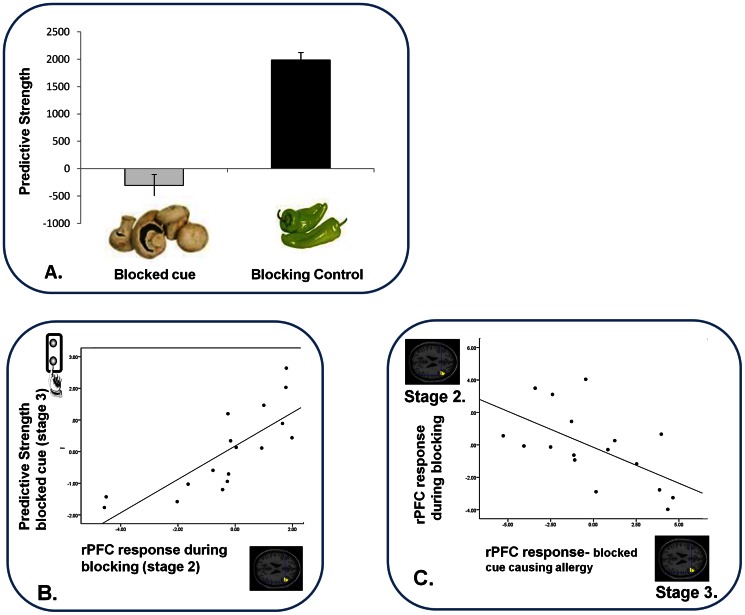
Blocking Behavior and its Relation to Brain Responses.
A. Behavioral Predictions For Blocked and Control Cues. Subjects predicted with low confidence about the blocked cue, when exposed to it at Stage 3; confirming that blocking had taken place. Error bars represent SEM. Y-axis represents subjects' predictive strength; their degree of confidence (duration of predictive button push response) multiplied by correctness of their prediction. Hence lower scores reflect uncertain and unstable predictions, which we observed to blocked cues when compared with blocking control cues (whose causal association with the allergy is more robust). B. Relating Predictions about the Blocked Cue (Stage 3) to Blocking Responses. Subjects who showed the lowest confidence when predicting what would happen following the blocked cue had the most attenuated right DLPFC response during blocking trials. X-axis represents the right DLPFC parameter estimates extracted from a contrast image comparing blocking trials with blocking control trials. Y-axis represents subjects' behavioral predictions about the blocked cues prior to seeing their predictive outcomes at the first trials of Stage 3. C. Relating Brain Responses During Blocking to those during Violation. Subjects with the most attenuated DLPFC response during blocking showed the greatest right DLPFC response when that blocking contingency was subsequently violated. X-axis represents the right DLPFC response to observing the blocked cue causing the allergic response during Violation (Stage 3), compared with control event. Y-axis represents right DLPFC response to blocking trials compared with blocking-control trials.